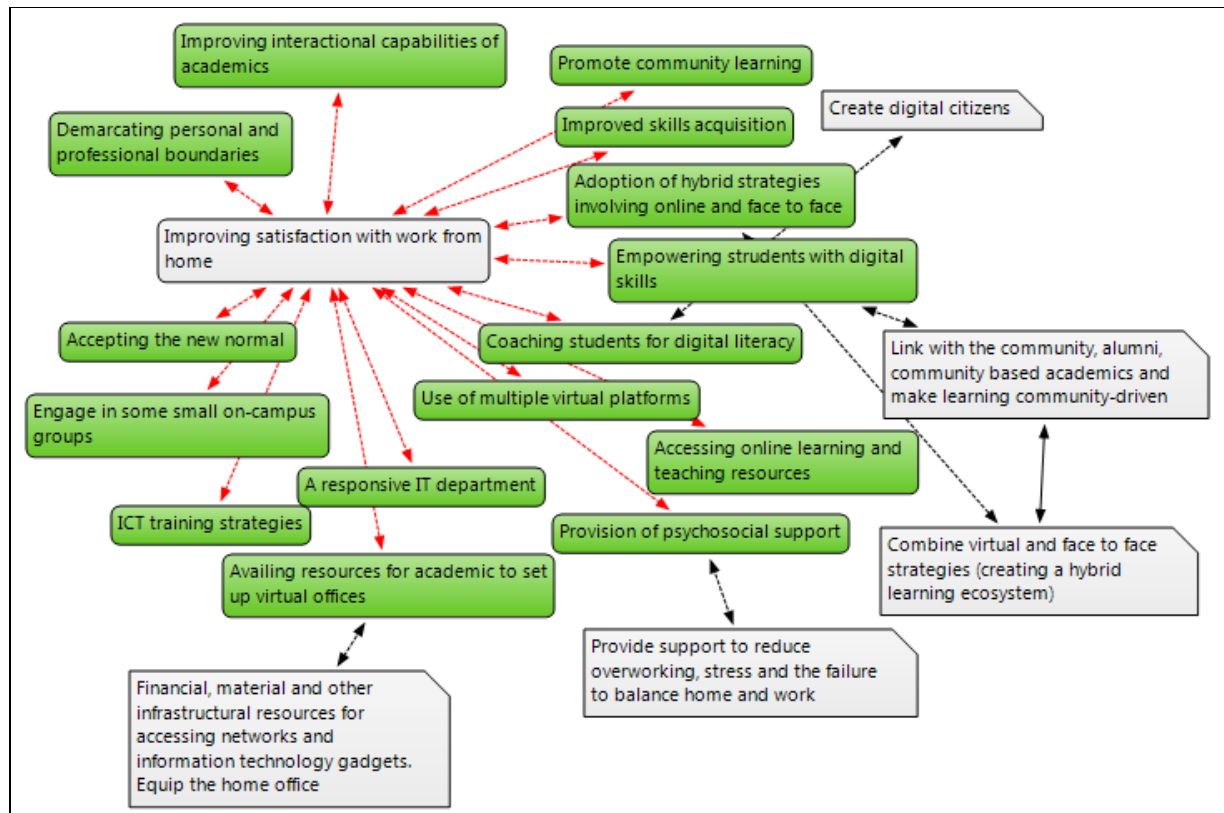
Figure 4. Strategies for successful work from home arrangements.